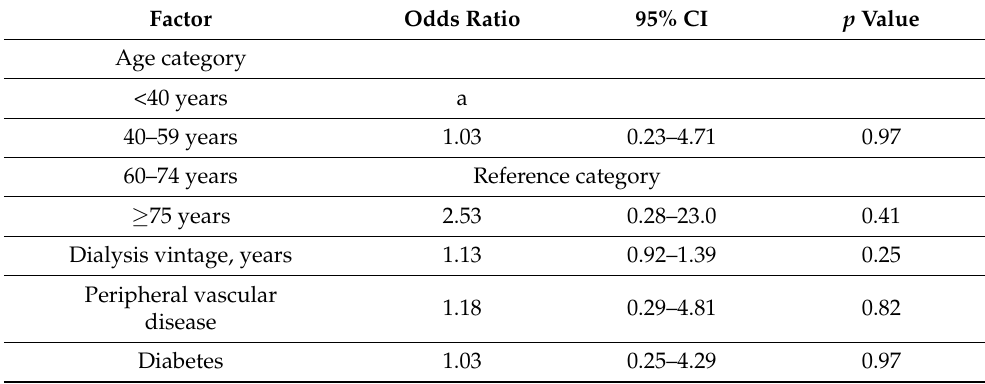
Table 4. Logistic regression analysis of factors associated with the presence of pain.